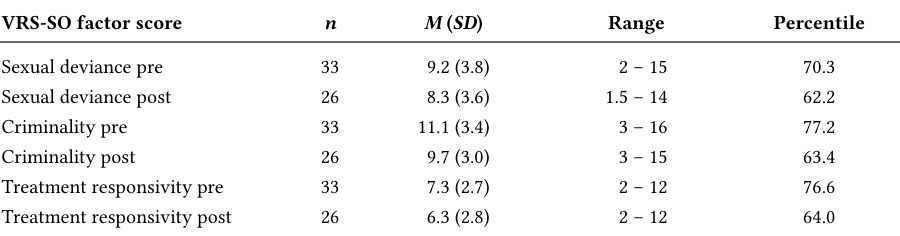
VRS-SO Criminogenic Need Information for Canadian Dangerous Offender Sample VRS-SO factor score n M ( SD ) Range Sexual deviance